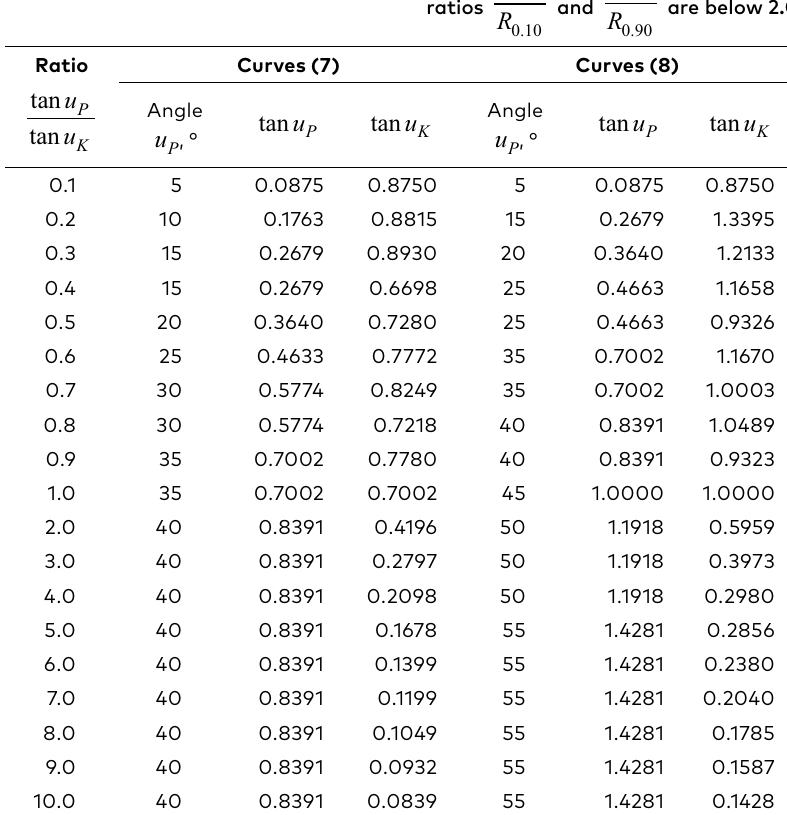
Table 2. Values tan u P and tan u K for